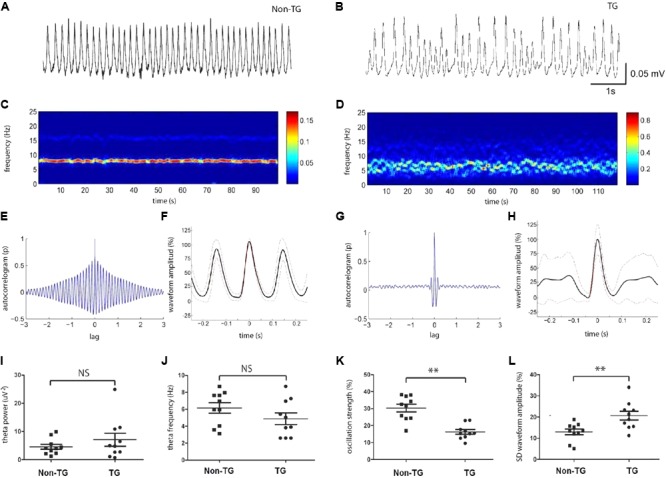
Hippocampal theta activity was disrupted in young J20 mice. Representative trace of theta oscillation recorded at hippocampal ca1/subiculum area from J20 transgenic (TG) mice at age of P30 (B), in comparison to the trace recorded from Non-transgenic (Non-TG) animal (A). Spectrogram (100 s) from the same recordings shown above (C,D). Autocorrelation of theta oscillations from TG and Non-TG mice (E,G). Averaged oscillation waveform from 100 s recordings with standard deviation (F,H, red dashed line). Statistics showed the oscillation power (I) and frequency (J) had no significant difference between TG and Non-TG group. (K) The oscillation strength from J20 group are significantly lower than those from the control group. (L) The standard deviation of the averaged waveform peak is significantly higher in J20 group compares to Non-TG group (n = 10 in each group, ∗∗p < 0.01 and NS p < 0.05).